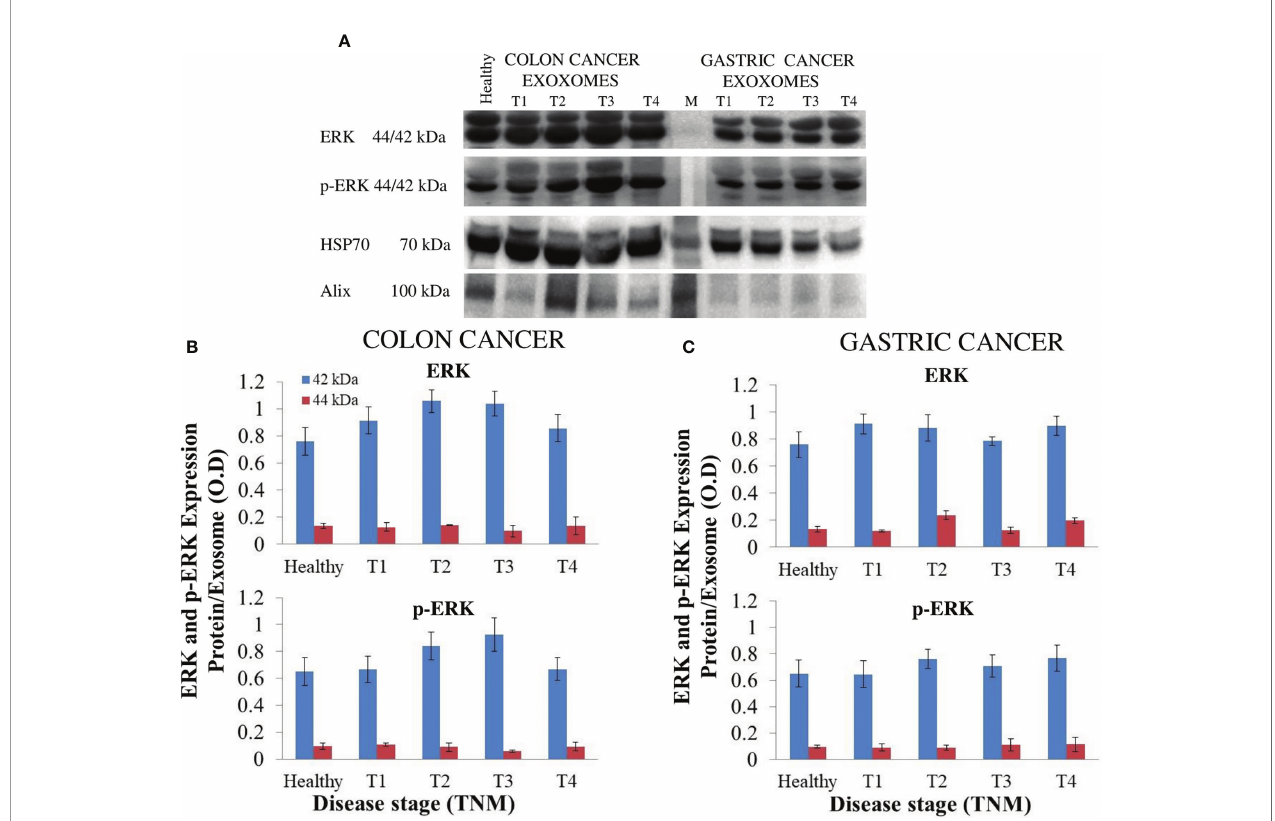
FIGURE 4 | Evaluation of extracellular signal-regulated protein kinase (ERK)1/2 and p-ERK1/2 in exosomes derived from plasma of (20) healthy donors and (26) colorectal cancer (CRC) or (20) gastric cancer (GC) patients at different TNM stages. Representative Western blotting of ERK1/2, p-ERK1/2, and the two marker proteins (HSP-70 and ALIX) in exosomes (A) . Semiquantitative evaluation of ERK1/2 and p-ERK1/2 expression level in exosomes isolated by plasma of CRC (B) and GC (C) patients at different TNM stages by video-densitometry analysis of bands of ERK1/2 and p-ERK1/2 proteins on Western blotting performed by using distinct gels and membranes for the different proteins. Healthy donors were used as control. HSP-70 protein band was used for the normalization of the ERK1/2 and p-ERK1/2 bands for each subject (B, C)